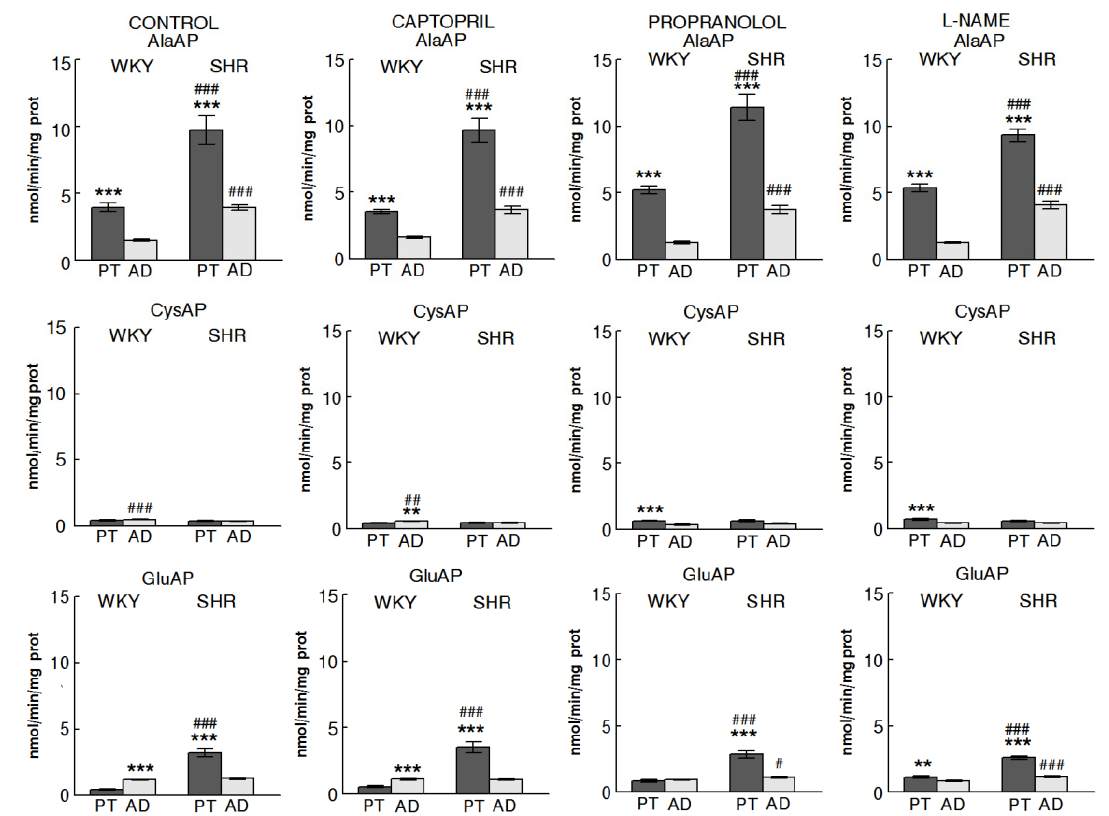
Figure 2. Regional differences of angiotensinase activities between pituitary (PT) and adrenal (AD) glands in Wistar–Kyoto (WKY) and spontaneously hypertensive rats (SHR). Bars represent Mean ± SEM levels of alanyl-aminopeptidase (AlaAP), cystinyl aminopeptidase (CysAP) and glutamyl-aminopeptidase (GluAP) activities, expressed as nmol/min/mg of proteins, in non-treated (control) or treated with captopril, propranolol or L-NAME. (*) differences between glands; (#) differences between strains for the same gland. Single sign (#, p < 0.05); double sign (**, ##, p < 0.01); triple sign (***, ###, p < 0.001).